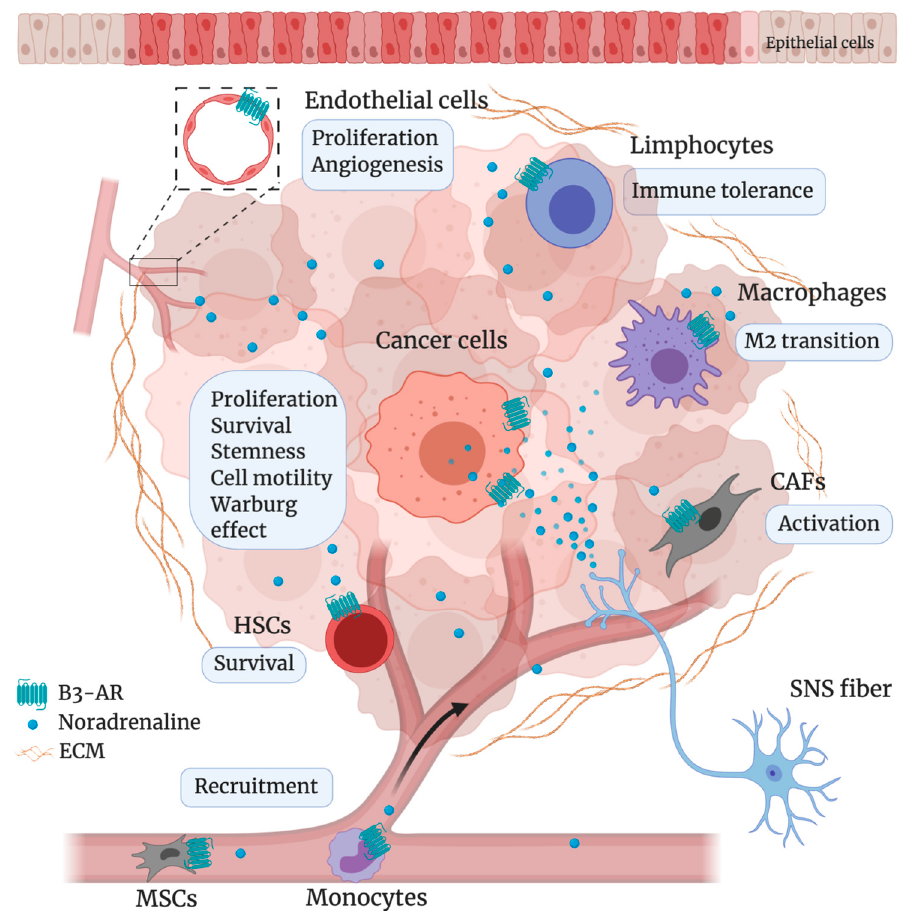
Figure 1. Schematic representation of β 3-AR-regulated processes in tumor and stromal cells of melanoma microenvironment (TME). A complex network of interaction and crosstalk between tumor and stromal cells of the TME, sustained through β 3-AR-enanched processes, promotes melanoma progression. (CAFs = cancer-associated fibroblast; ECM = extracellular matrix; HSCs = hematopoietic stem cells; M2 = macrophage type 2; MSCs = mesenchymal stem cells; SNS = sympathetic nervous system). Created with BioRender.